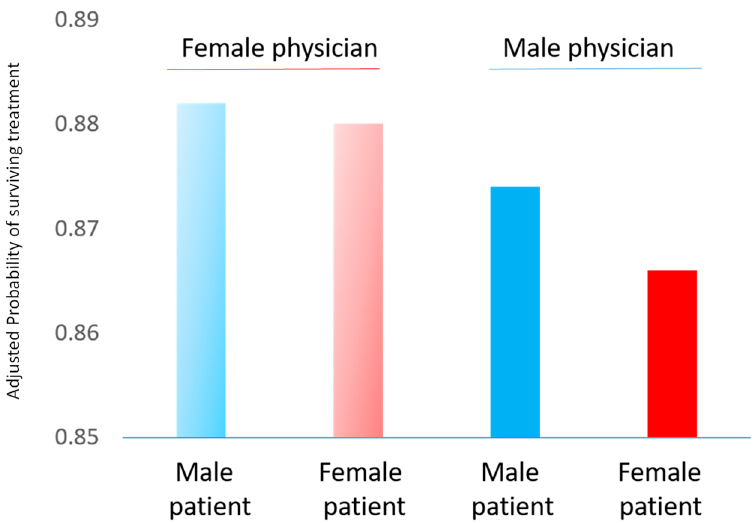
Figure 4. Probability of survival from cardiac treatment in Florida emergency departments, 1991–2010, showing results separately according to the sex of the physician attending and the sex of the patient. This figure was drawn using approximate results derived from the source paper [15].